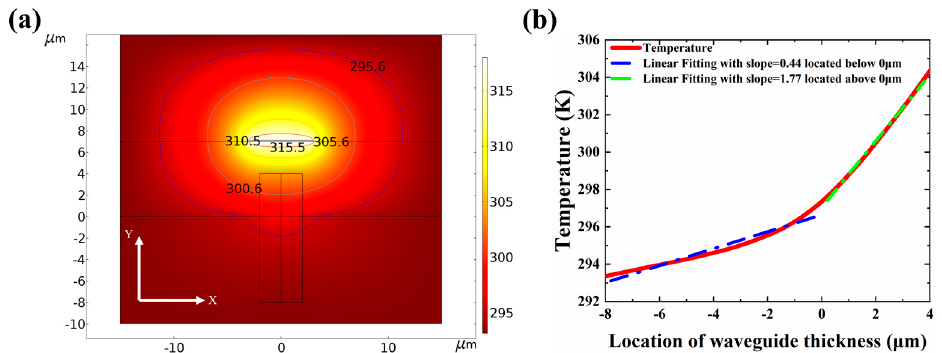
Figure 6. The simulation of the temperature distribution of VOA. ( a ) The thermal field distribution of the VOA. ( b ) The specific value of the change of the temperature in the Y direction with the position distribution.